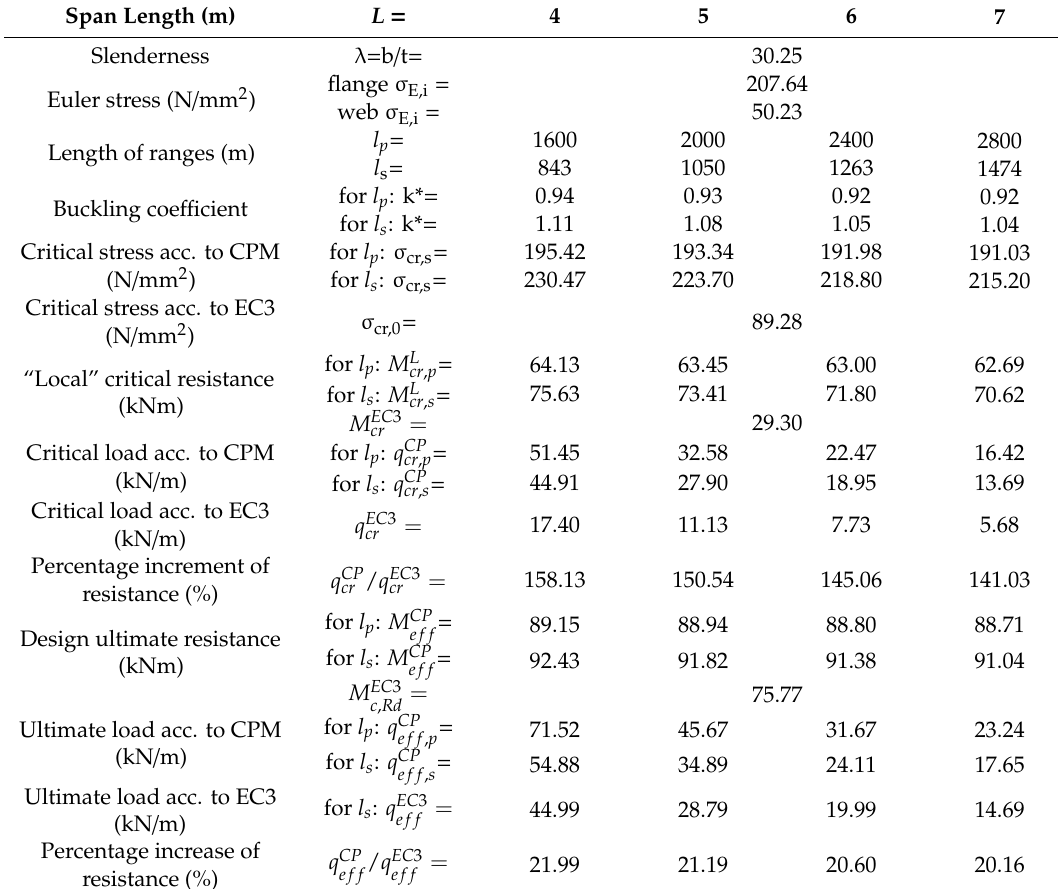
Table 4. Summary of results according to CPM and EC3 for the 2C-250 × 250 × 4 section and four span-length range